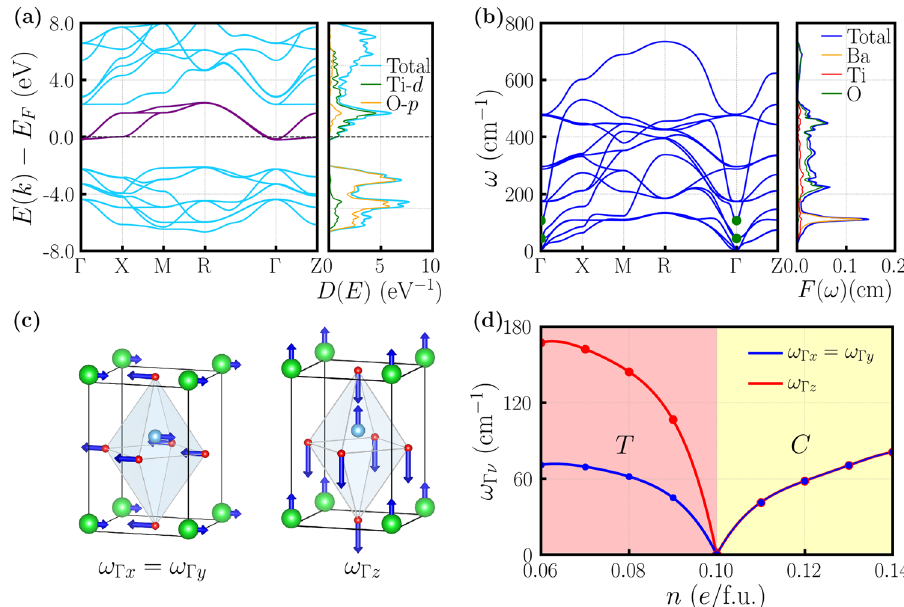
Fig. 2 Electronic structure and phonon properties of doped BaTiO 3 . a Electronic band structure and density of states of doped BaTiO 3 in the tetragonal structure at 0.09 e /f.u. concentration. In the electronic band structure, the three purple bands are generated by three maximally localized Wannier functions that exactly reproduce the original Ti t 2 g bands. In the electronic density of states, the blue, green and orange curves correspond to total, Ti- d projected and O- p projected partial densities of states, respectively. b Phonon band structure and phonon density of states of doped BaTiO 3 in the tetragonal structure at 0.09 e /f.u. concentration. In the phonon band structure, the green dots highlight the zone-center polar optical phonons. In the phonon density of states, the blue, orange, red and green curves correspond to total, Ba-projected, Ti-projected and O-projected partial densities of states, respectively. c Vibration modes of the zone-center polar optical phonons of doped BaTiO 3 in the tetragonal structure at 0.09 e /f.u. concentration. The left panel shows that the atoms of BaTiO 3 are vibrating along the short a axis (either x -axis or y -axis, degenerate due to the tetragonal symmetry). The right panel shows that the atoms of BaTiO 3 are vibrating along the long c axis ( z -axis). d The frequencies of the three zone-center polar phonons of doped BaTiO 3 as a function of electron concentration n . The critical concentration is at 0.1 e /f.u. where the polar phonon frequencies are reduced to